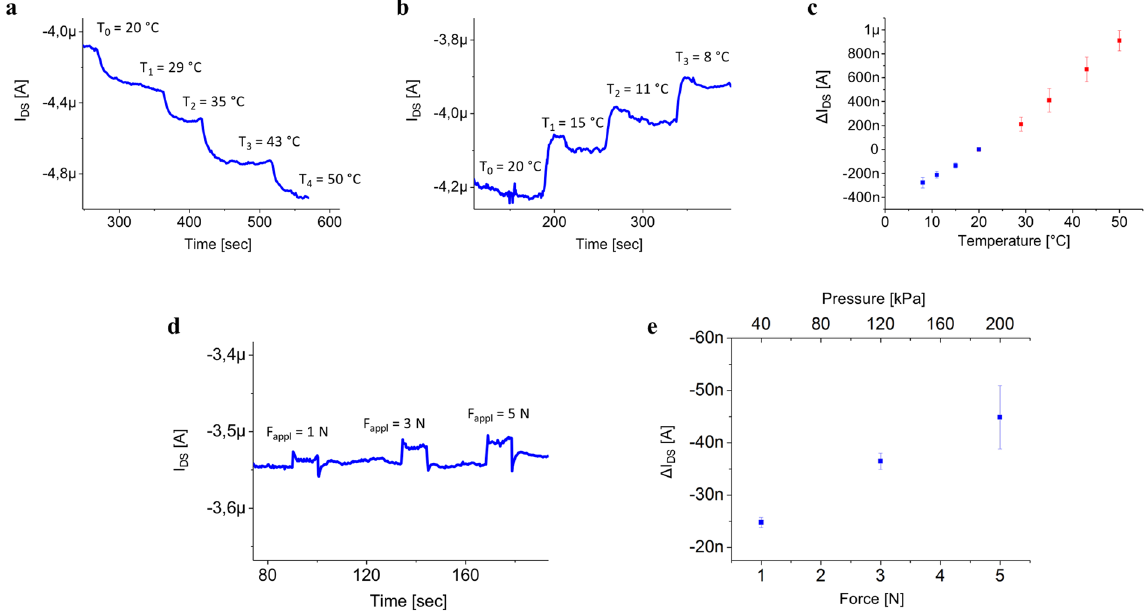
Figure 2. OCMFET electrothermal and electromechanical characterization. ( a–b ) Variations in the OCMFET current (I DS ) upon the application of a thermal stress to the PVDF capacitor coupled to the floating gate. ( c ) Calibration curves of the sensor, blue (red) points represent the variations of the output current for temperature decrease (increase). The device exhibited a reproducible linear response in the range 8 °C–50 °C. ( d ) Variations in I DS upon the application of mechanical stress to the PVDF capacitor coupled to the floating gate. ( e ) Electromechanical characterization of the sensor.